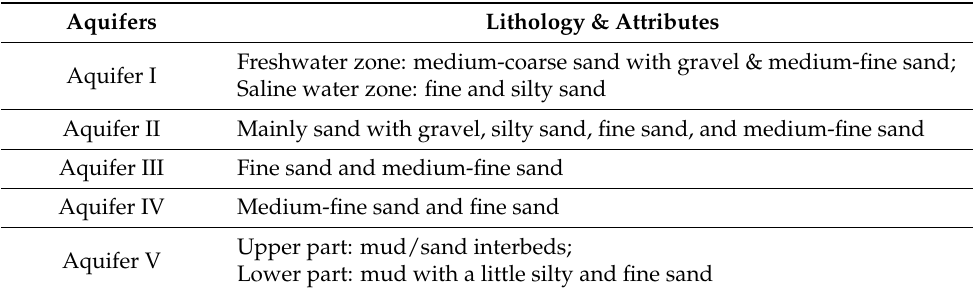
Figure 2. Sketch pro fi les of strati fi ed aquifers: Aquifer I (40~60 m thickness), Aquifer II (25~60 m thickness), Aquifer III (30~55 m thickness), Aquifer IV (30~50 m thickness), and Aquifer V (20~30 m thickness). ( a ) The pro fi les’ location; ( b ) the pro fi le from north to south; ( c ) the pro fi le from west to east. (Modi fi ed from [3,8]). Table 1. Lithology of each aquifer ([3,8]).